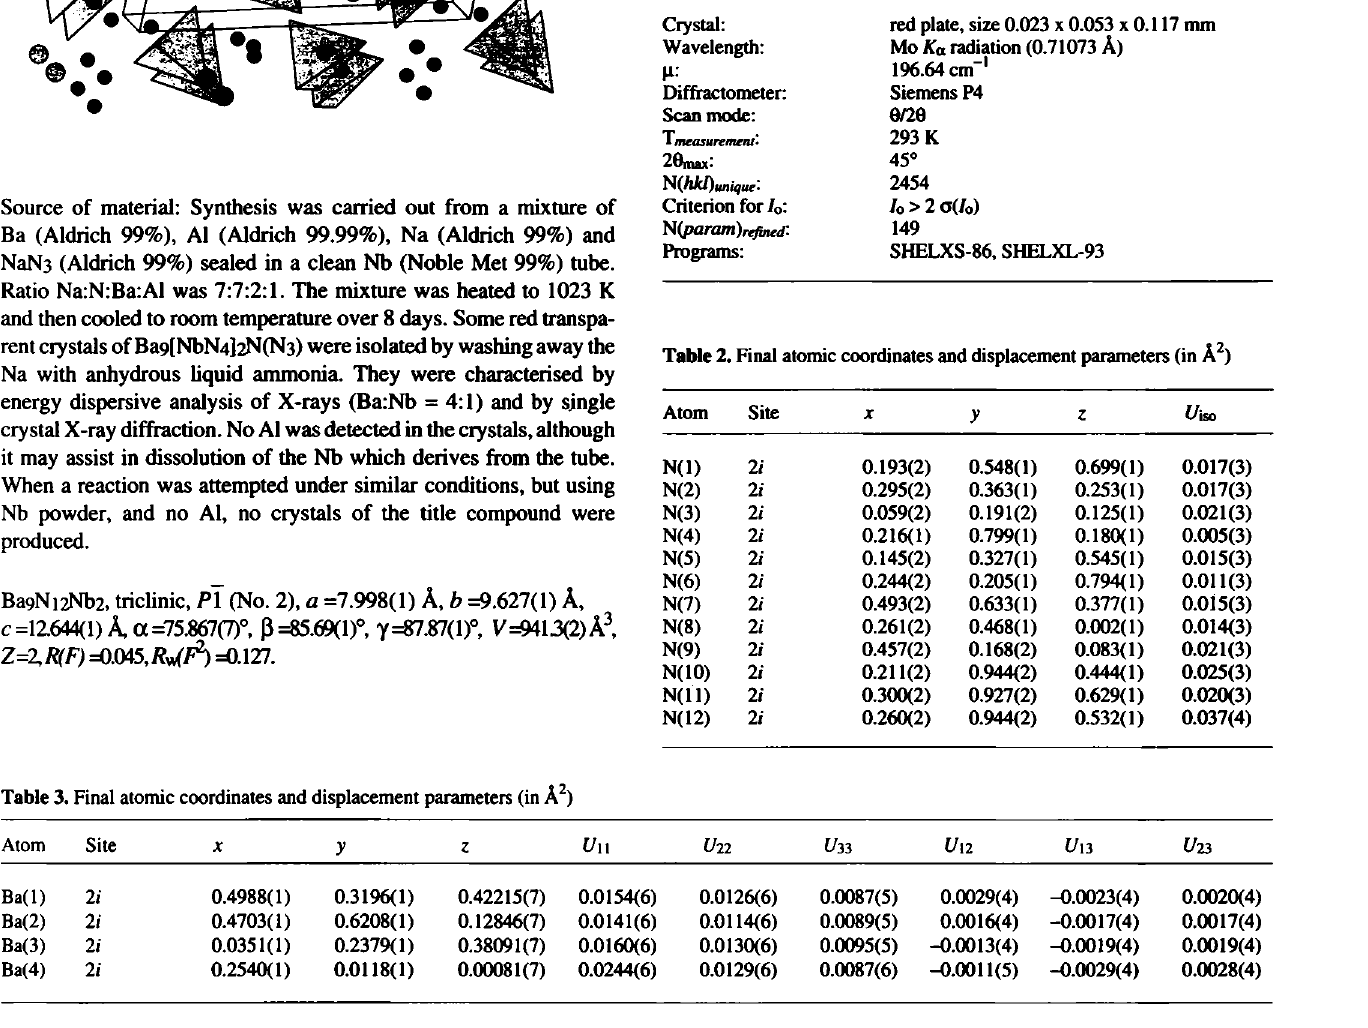
Table 1. Parameters used for the X-ray data collection Crystal: